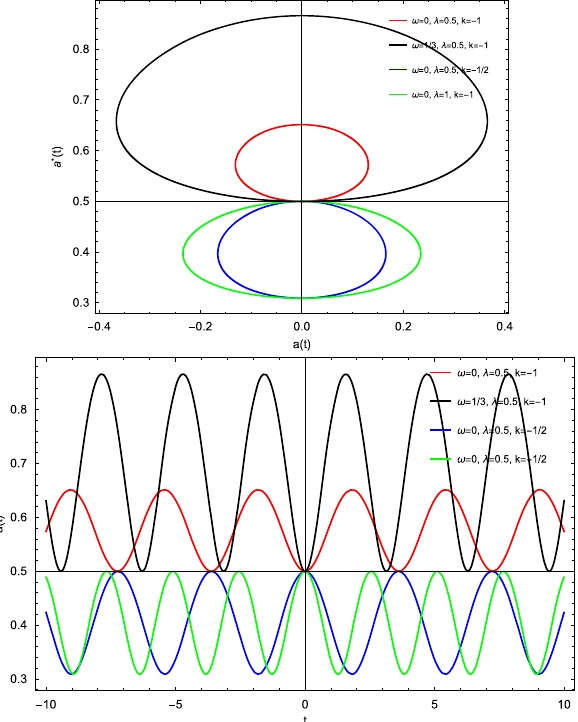
Fig. 2 The upper plot represents some closed trajectories in the phase- space ( ˙ a ( t ), a ( t )) for the given typical values of the parameters satis- fying the existence and stability conditions in Table 2. The lower plot represents the evolution of the corresponding scale factors (as a func- tion of time) to each of the closed trajectories in the phase space. The corresponding cases are in the same